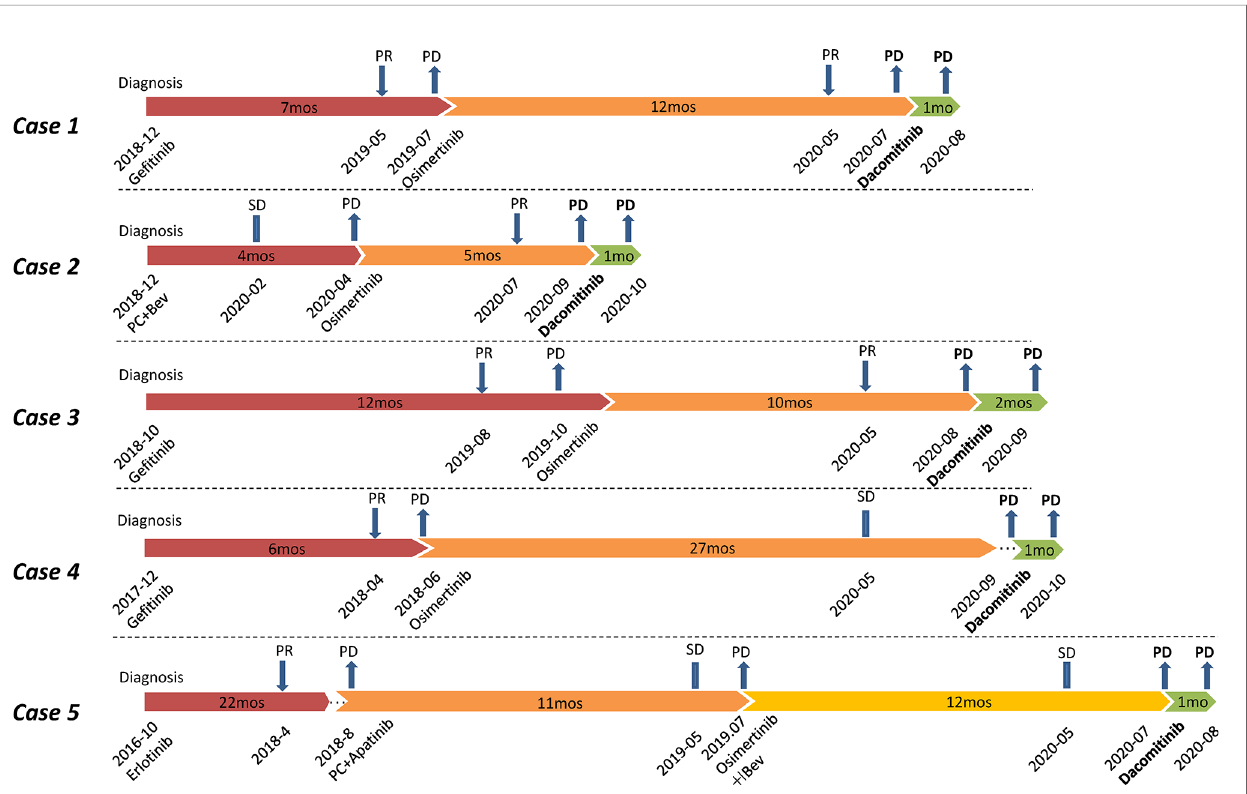
FIGURE 1 | Flow chart of treatments for Case 1-5. All patients were treated with dacomitinib after osimertinib resistance. PR, partial response; SD, stable disease; PD, progressive disease; PC, pemetrexed plus carboplatin; Bev, bevacizumab; mos,